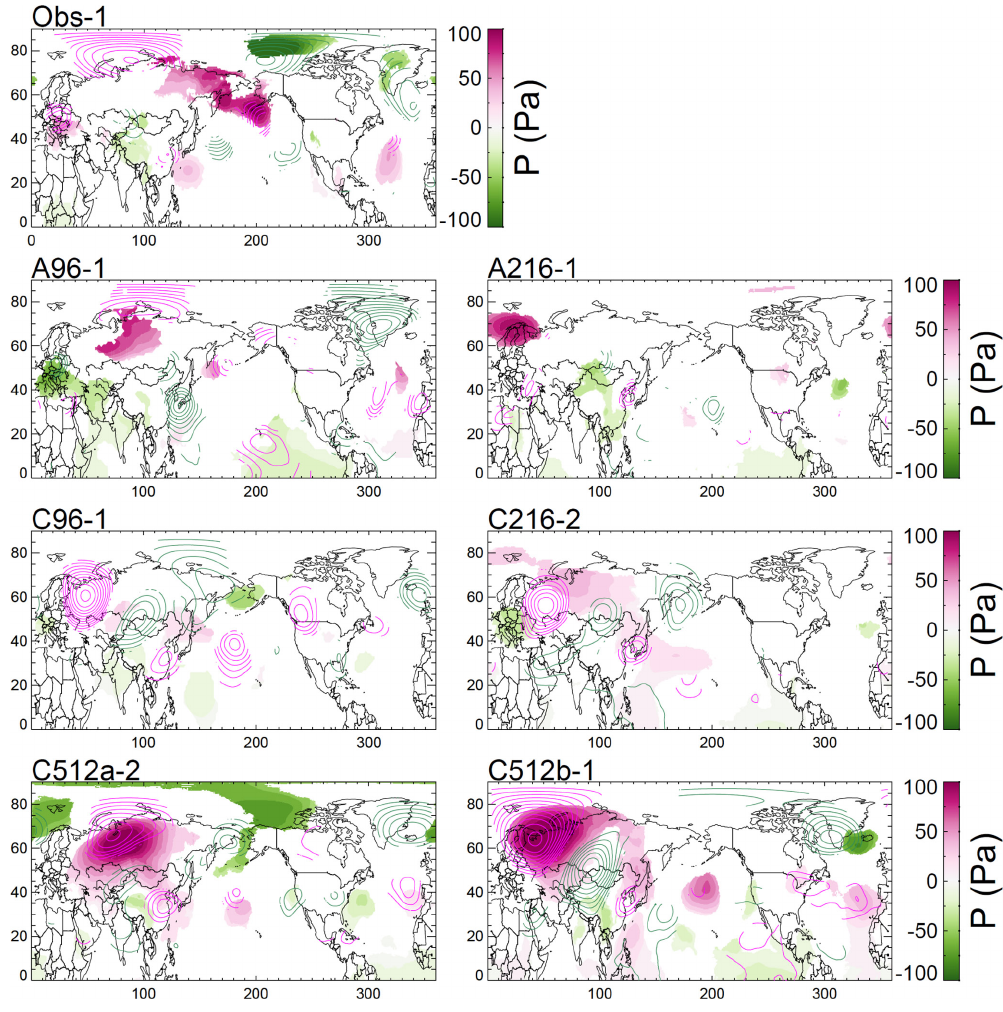
Figure 12. Regressions of P SFC (shading) and Z 200 (contours at intervals of 0.02m; pink – positive; green – negative) against normalised SON EOT time series corresponding to Obs-1. All shown values are significant at the 90% confidence